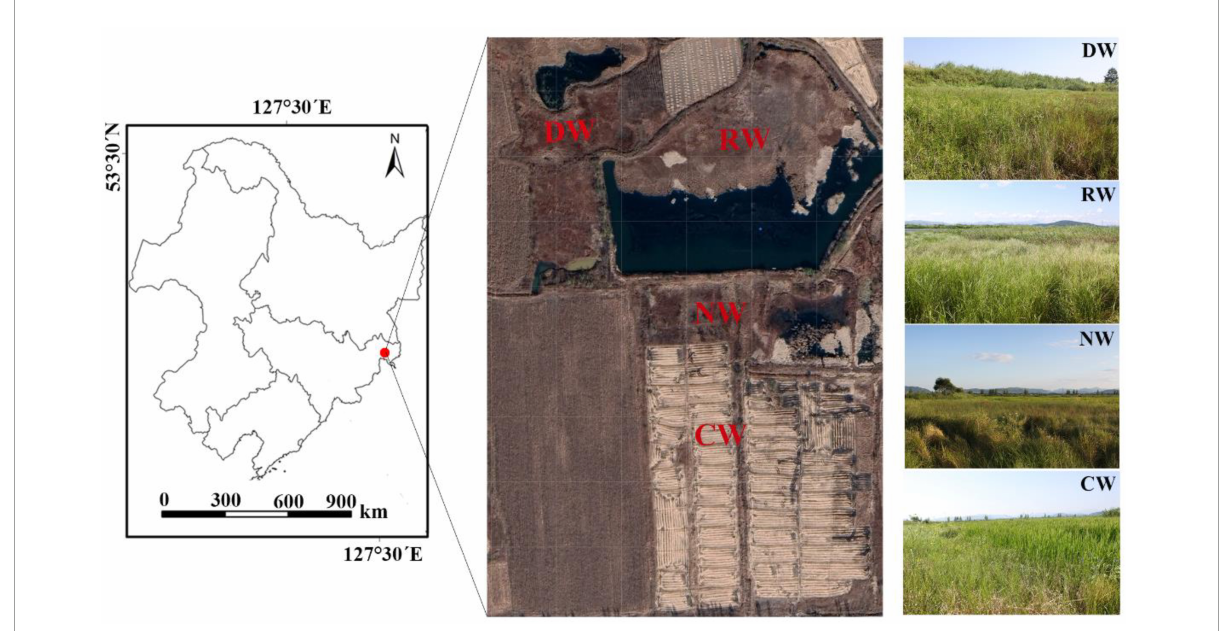
FIGURE1 Map of the wetland study sites downstream of the Tumen River. RW, reference wetlands; DW, drained wetlands; NW, nutrient-rich wetlands; CW, cultivated